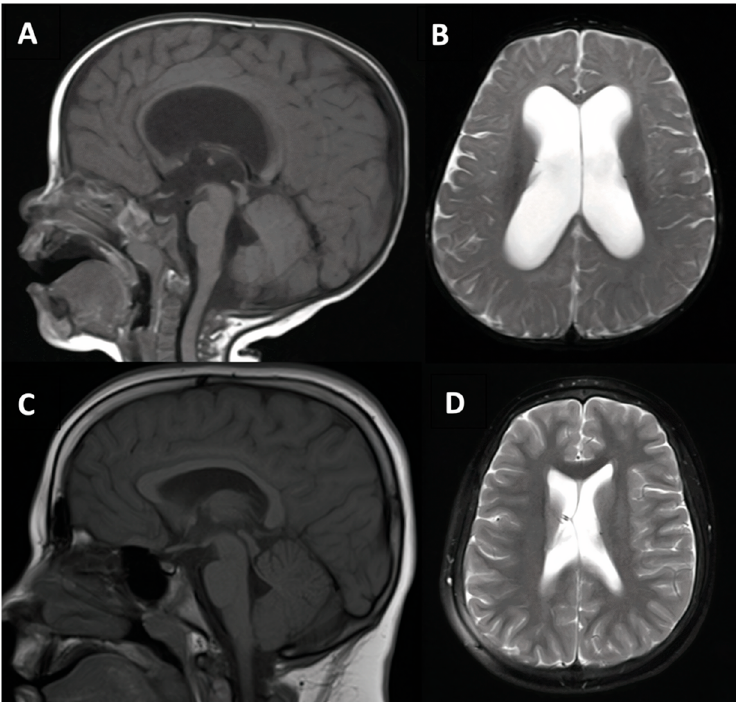
Figure 4. 18-month-old female patient with premature birth and developmental delay (case #4).